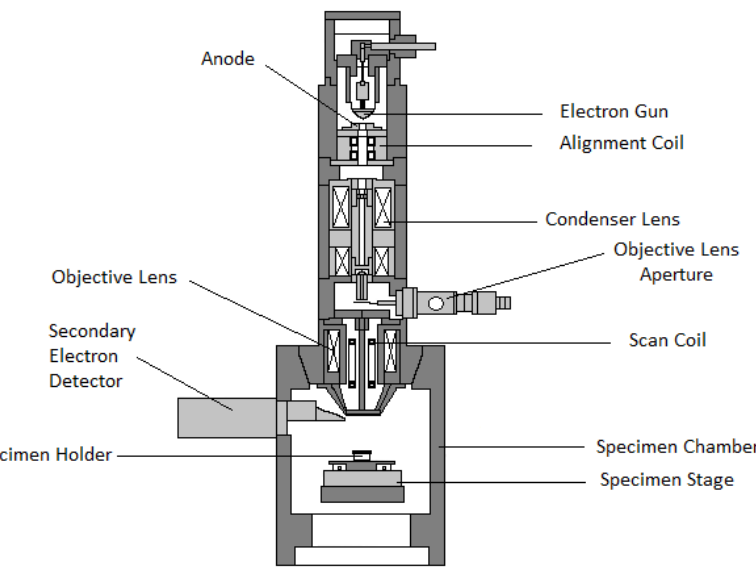
Figure 3. Scanning electron